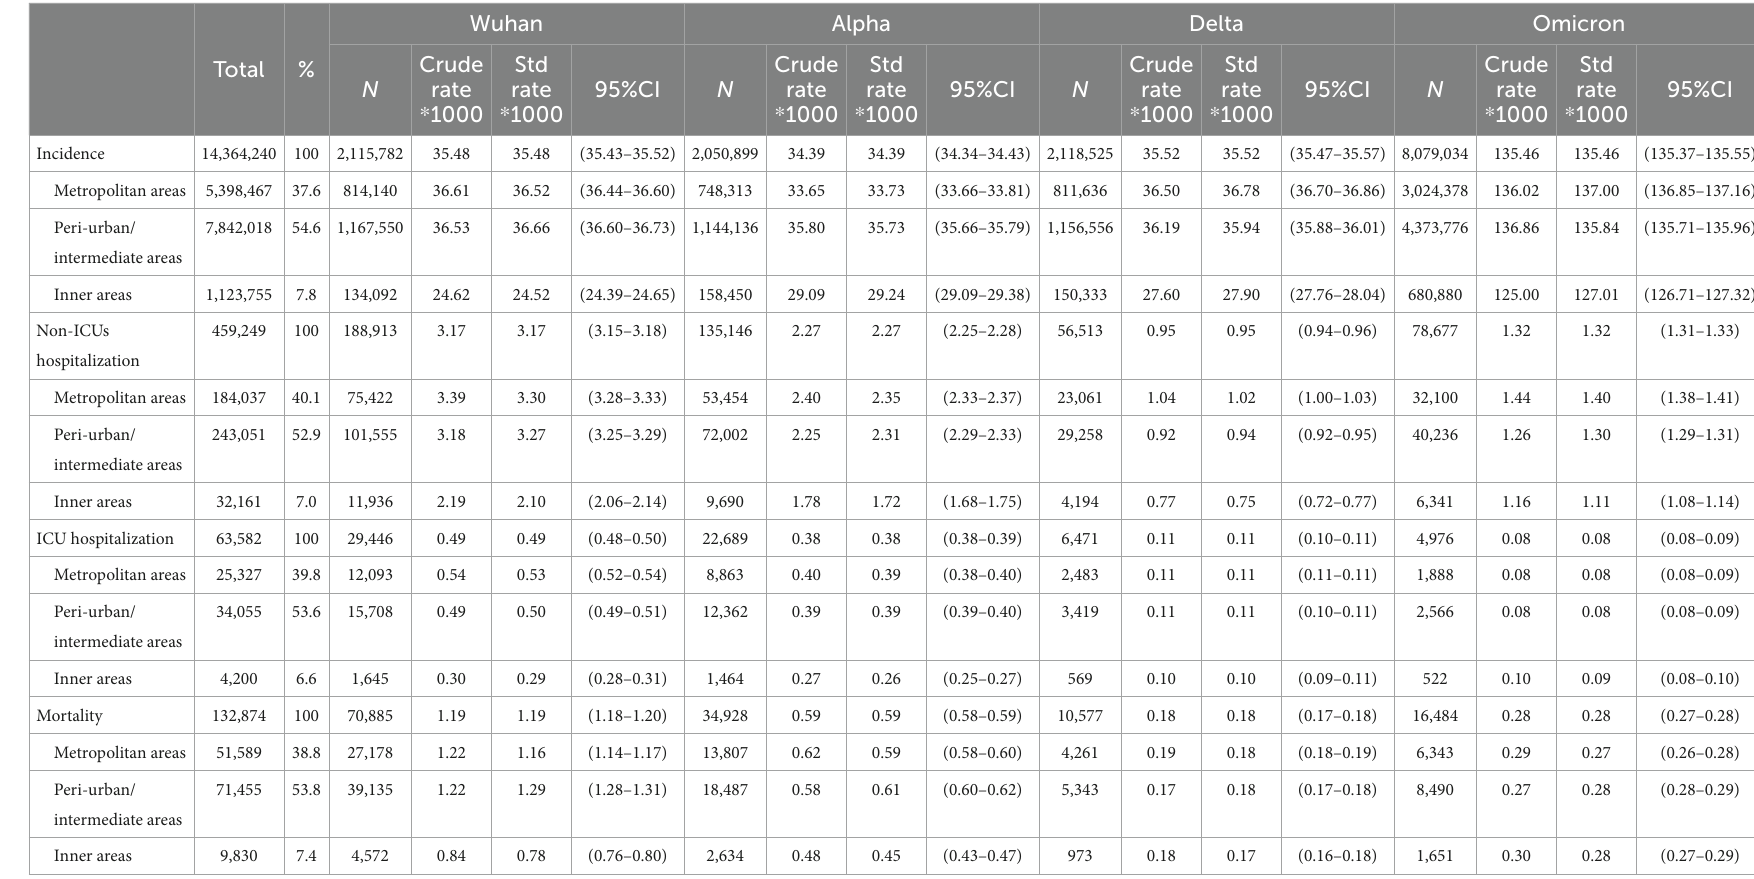
TABLE 2 Distribution of COVID-19 cases, non-ICU and ICU hospital admissions, and deaths. Crude and age-standardized rates, with 95% confidence intervals (CI) for all the study outcomes, by class of municipalities and time